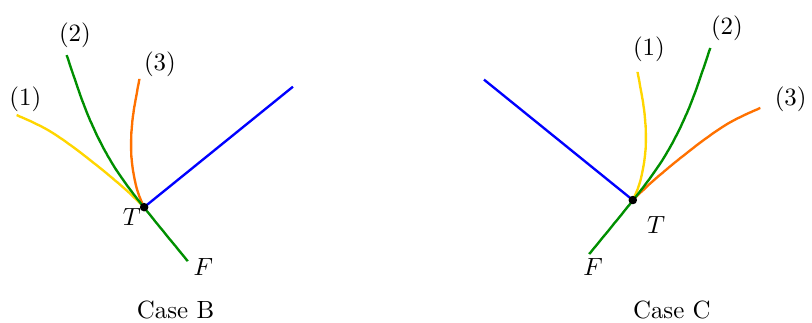
Figure 17 . Different possibilities for the first order curve F 0 , labelled as (1) , (2) and (3) , in relation to the first order curve F . The two subfigures differ in the relative placements of the second order line (blue) and the first order